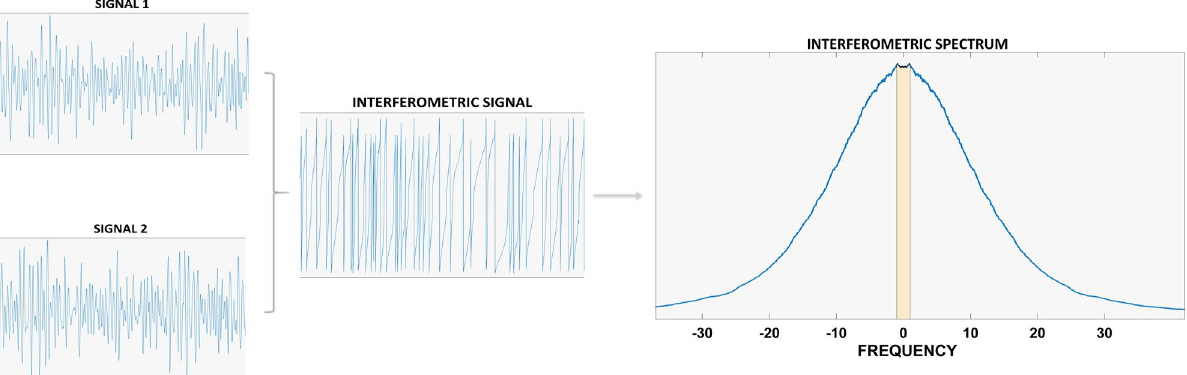
Figure 5. Phase linearity measurement, used to estimate synchronization. The time series of each pair of regions have been processed to obtain the interferometric signal. The power spectrum of the